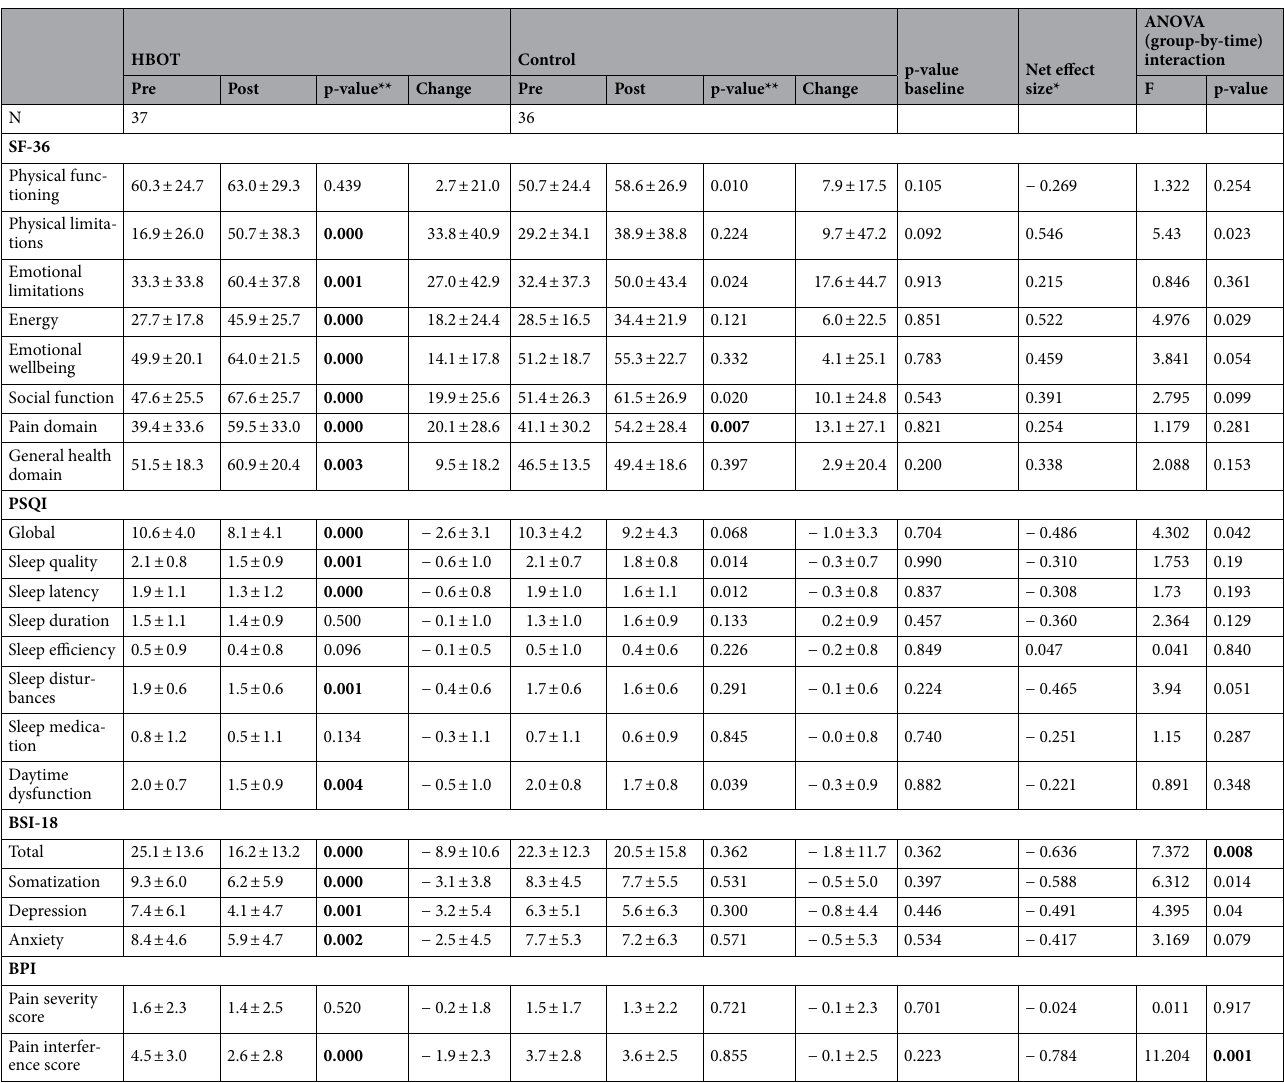
Table 3. Questionnaire results analysis. Data are presented as mean ± SD; Bold, significant after Bonferroni correction; *Cohen’s d net effect size; **Pre-post treatment/sham p-value. The follow up assessments were performed 1–3 weeks after the last treatment